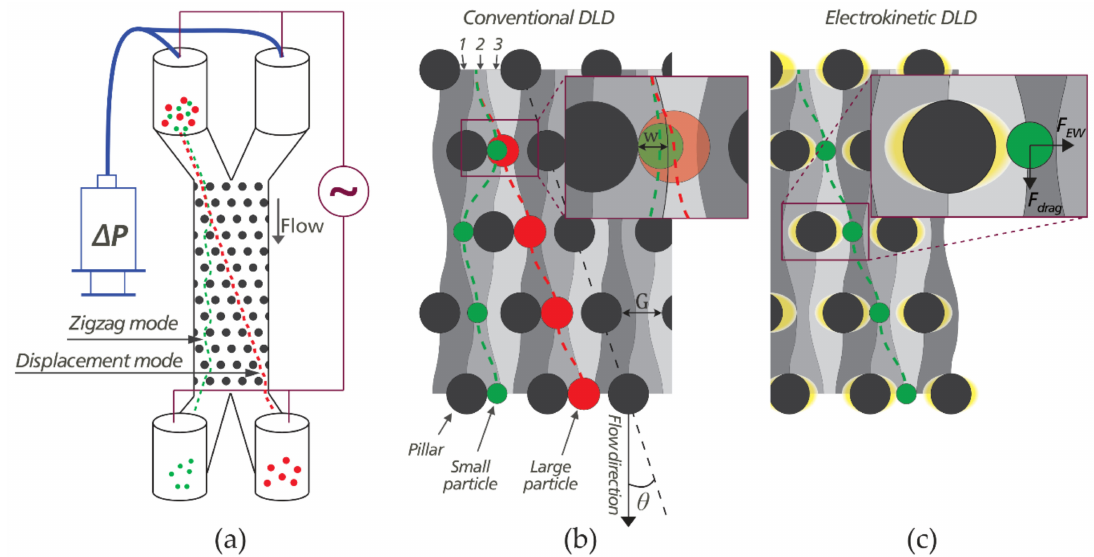
Figure 1. Working principle of conventional Deterministic Lateral Displacement (DLD) and DLD with electric fields (eDLD). ( a ) Diagram of a typical DLD device. The device is driven by a pressure di ff erence between inlets and outlets and is capable of sorting a mixture of particles by size. Electrokinetic e ff ects are added by applying a voltage along the device. In this case, the average field is parallel to the flow. ( b ) Mechanism of conventional DLD. Separation is a result of consecutive migration of large particles across di ff erent flow streams (here numbered 1, 2, 3) due to steric interactions with the pillars. ( c ) In eDLD, the particle trajectories are modified by electrokinetic wall force fields around the